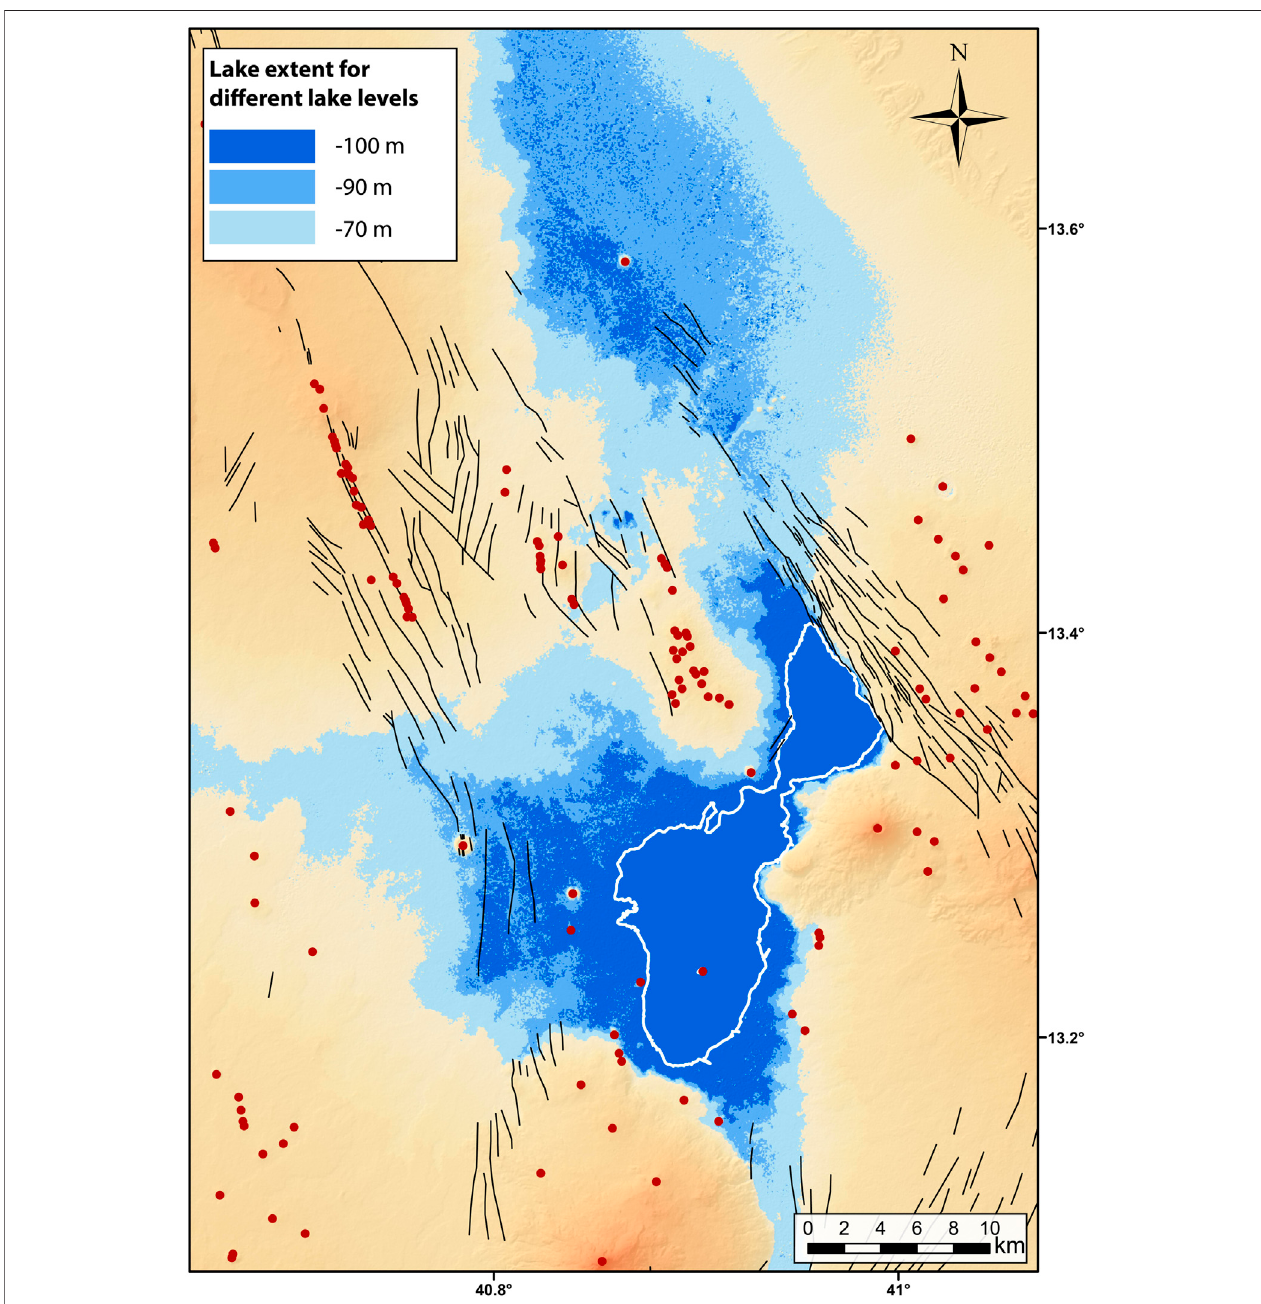
FIGURE 4 | Map showing the potential extent of Lake Afdera assuming lake level elevation of − 100, − 90 and − 70 m asl.